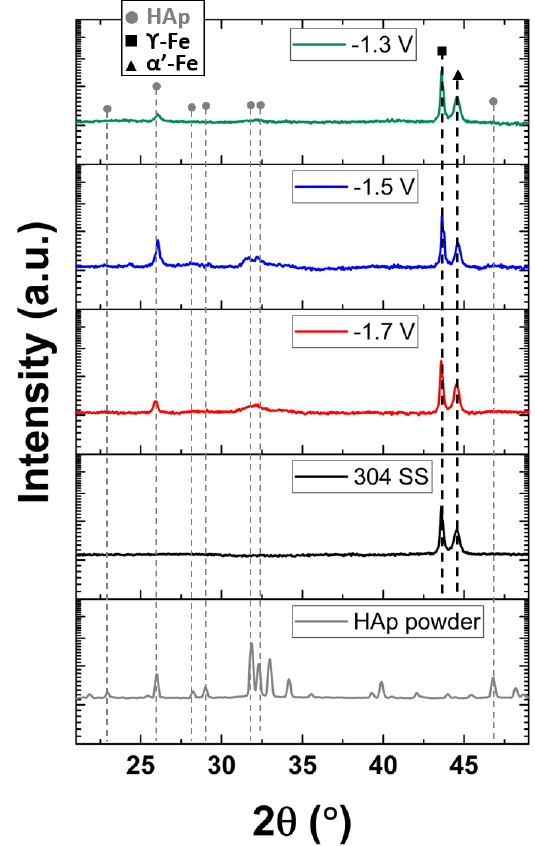
Figure 5. X-ray diffraction patterns of HAp coatings deposited onto 304 SS plates under different electrodeposition potentials, a bare 304 SS plate, and the HAp powders. The intensity ( Y -axis) is plotted using a logarithmic scale. Coatings 2020 , 10 , x FOR PEER REVIEW